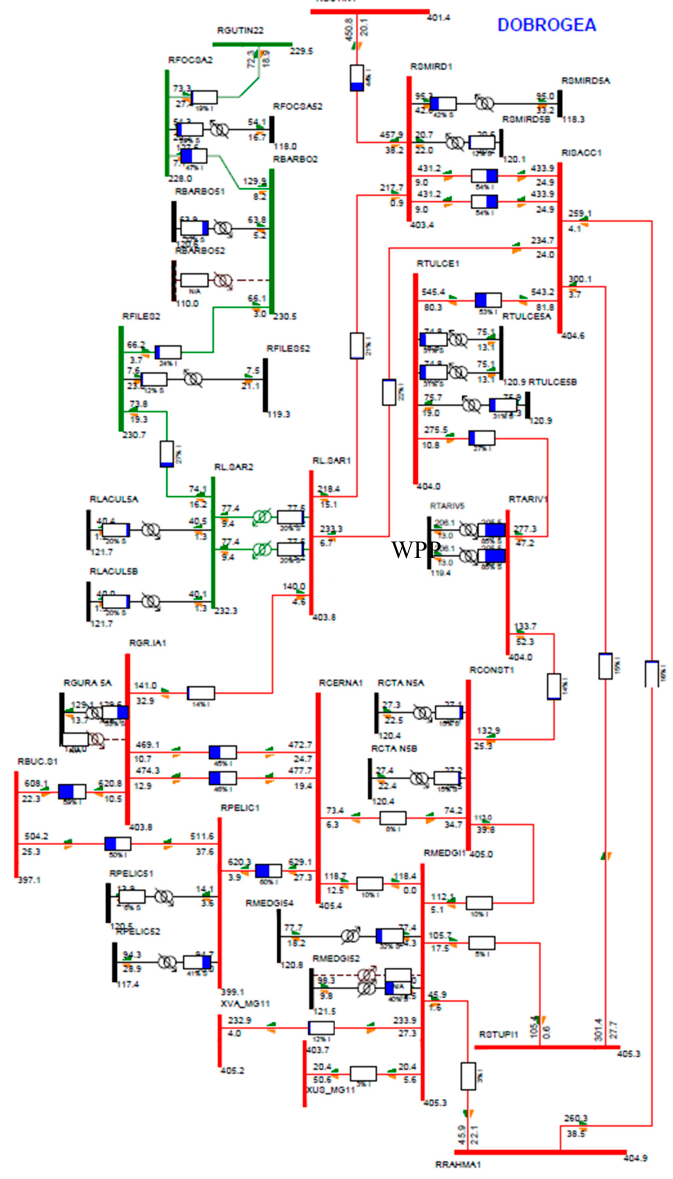
Figure 4. Dobrogea area in the case with N elements in operation.